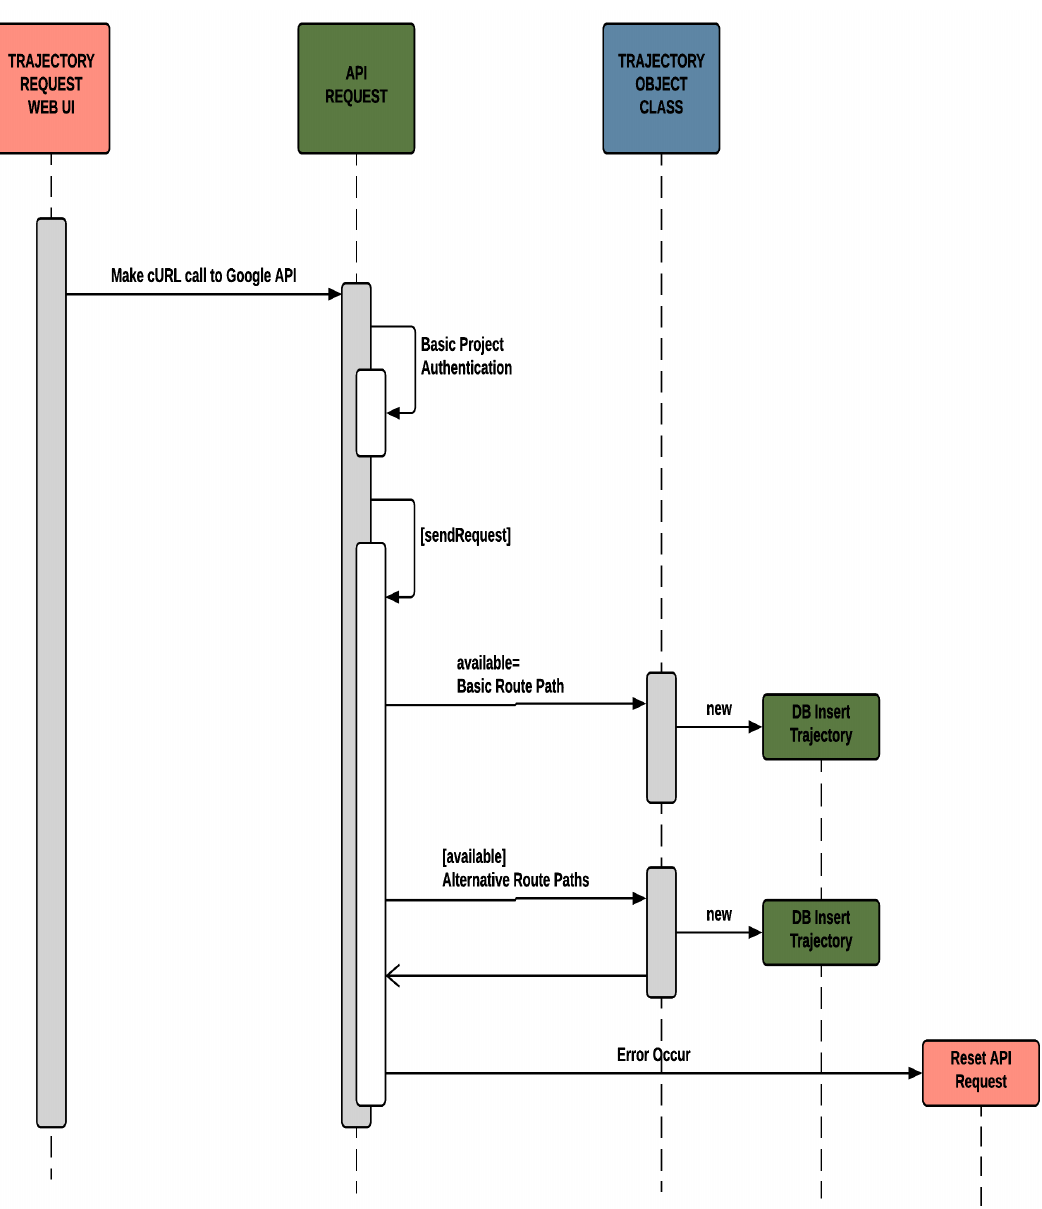
Figure 2. API request